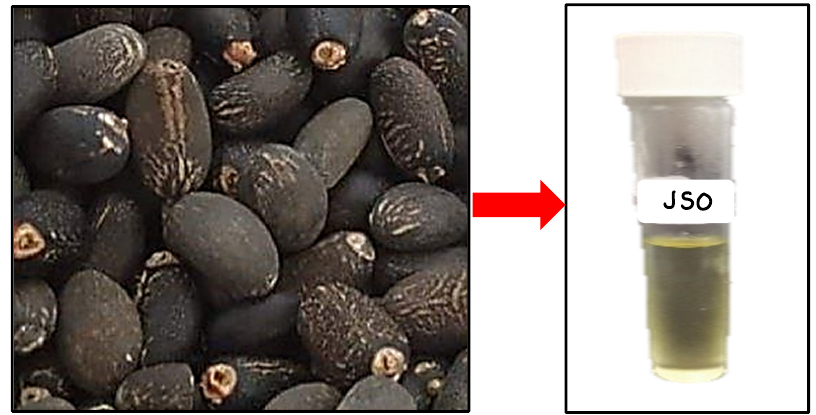
Figure 8. Malaysian Jatropha seed oil.